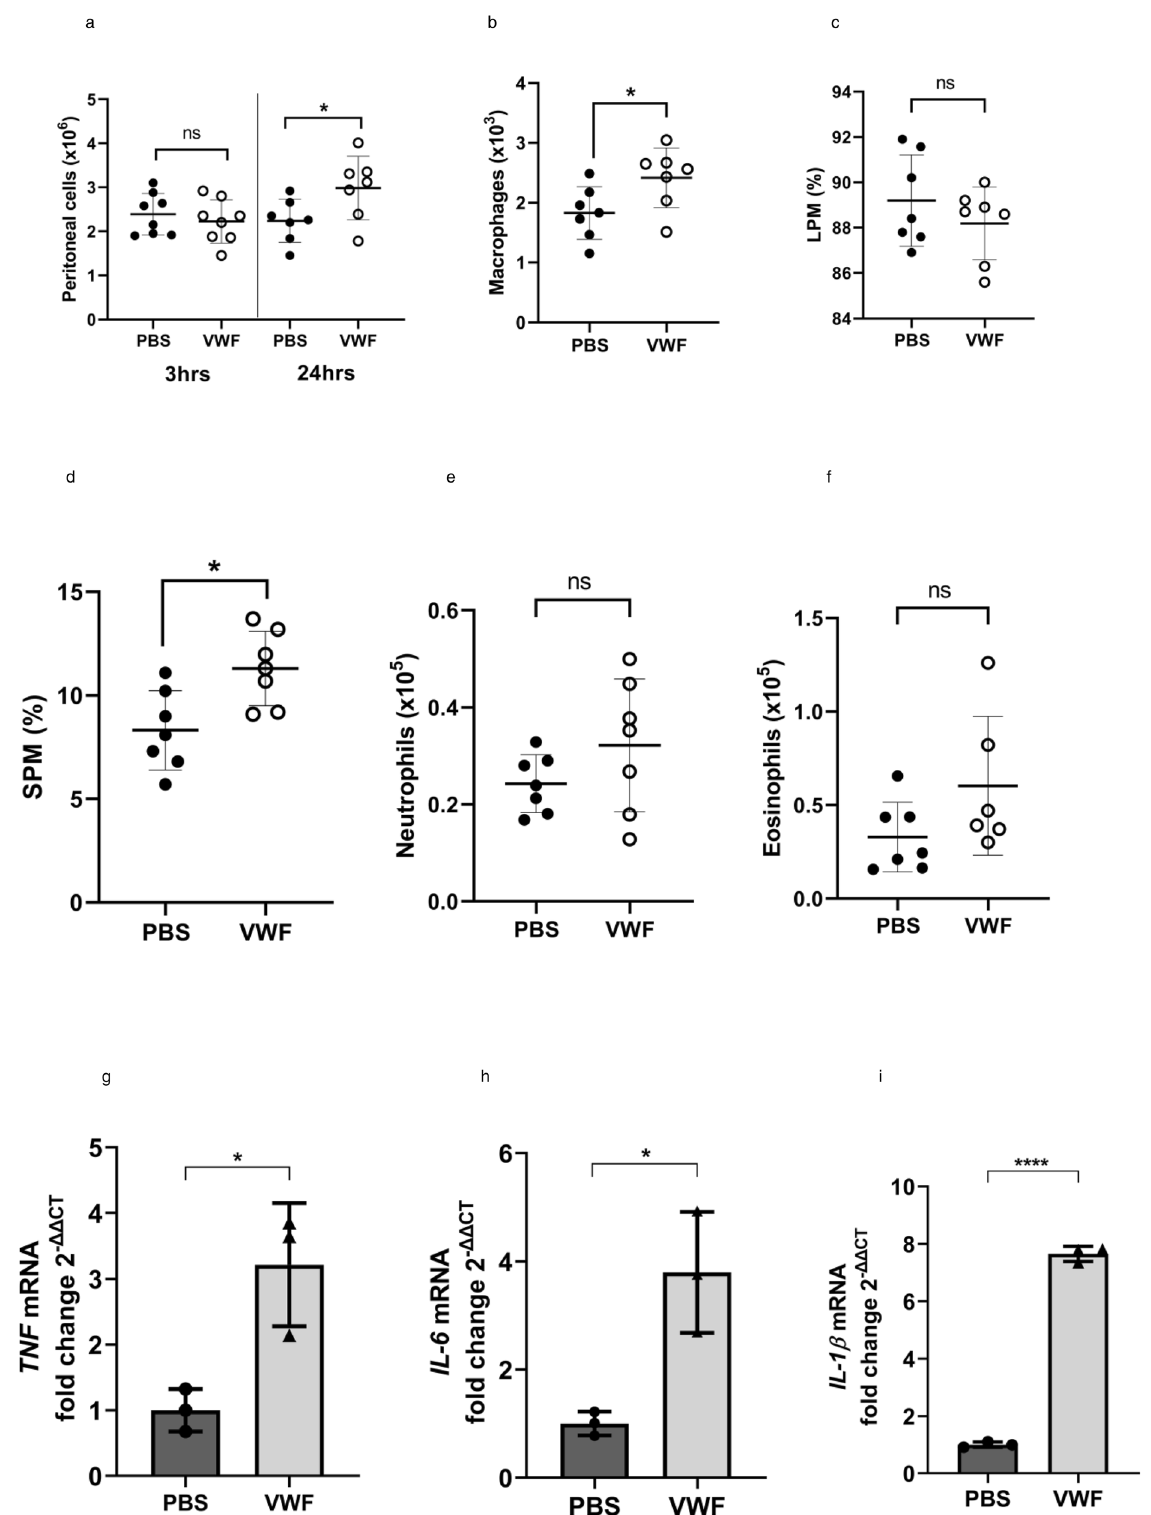
Fig. 9 | Intraperitoneal injection of VWF activates macrophages in the perito- neal cavity of mice. Mice were injected IP with VWF (2mg/kg) or PBS (control). After 3 or 24h post-injection periods, mice were sacri fi ced, peritoneal lavage per- formed and peritoneal exudate cells (PEC) recovered and analyzed by fl ow cyto- metry (see Supplementary Fig. 10) and gene expression analyzed by qPCR. a Total numbersofPECcellsrecoveredfrommice( P =0.508and* P =0.0428for3and24h respectively). b Numbersofmacrophages present inPEC ofmice (* P =0.0383)and relative frequency (%) of c large peritoneal macrophages (LPM) ( P =0.320 and d small peritoneal macrophages (SPM) (* P =0.0108). Numbers of e neutrophils